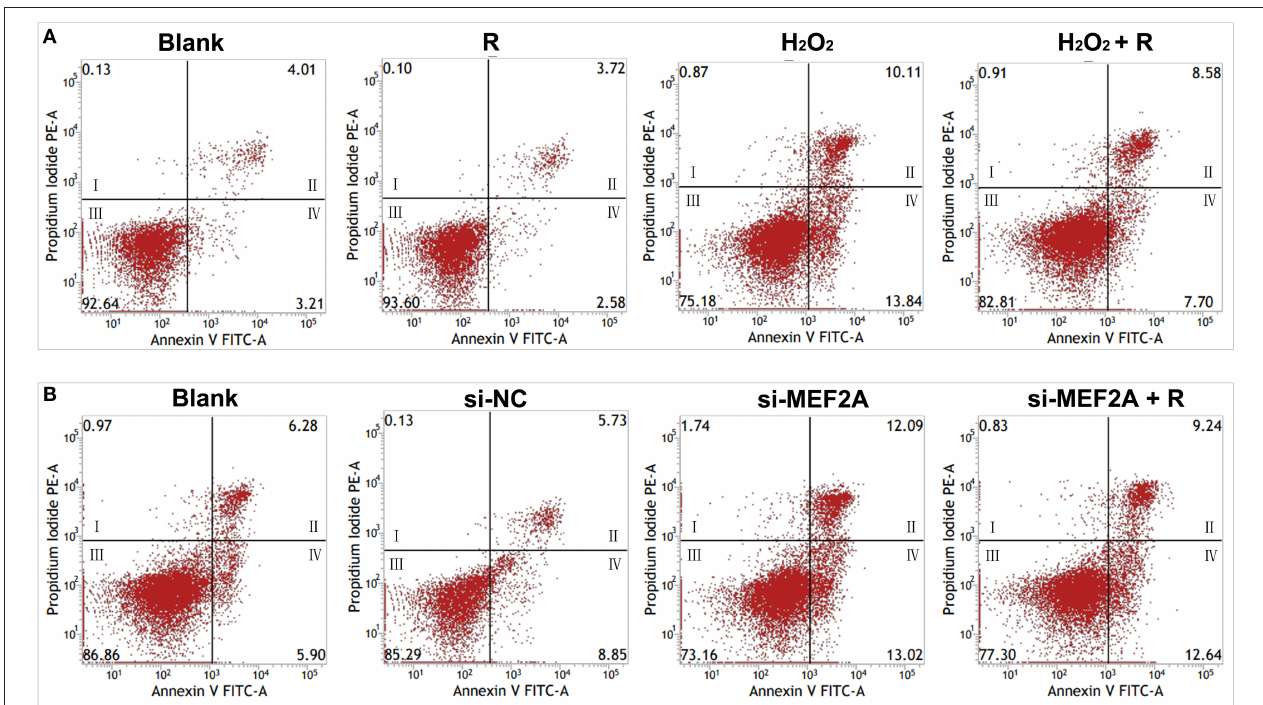
FIGURE 5 | The impact of resveratrol on the apoptosis caused by the treatment with H 2 O 2 or by silencing MEF2A with siRNA. (A) Using flow cytometry to test the impact of resveratrol on the apoptosis of HUVEC treated with or without H 2 O 2 . (B) Using flow cytometry to detect the impact of resveratrol on the apoptosis of HUVEC caused by down-regulated MEF2A with siRNA. R, resveratrol; Si-NC, the negative control of siRNA; Si-MEF2A, MEF2A specific siRNA. I: dead cells (Annexin V-FITC − /PI + ); II: late apoptotic/necrotic cells (Annexin V-FITC + /PI + ); III: non-apoptotic cells (Annexin V-FITC − /PI − ); IV: early apoptotic cells (Annexin V-FITC + /PI −